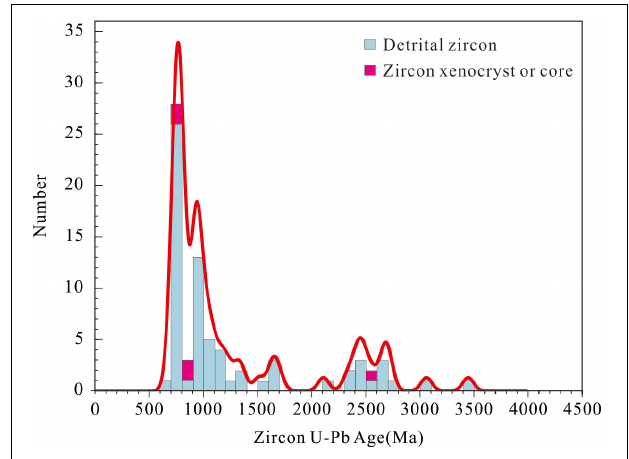
FIGURE 8 | Probability plot of detrital and xenocryst zircons from samples 15KT12, 15KT34, 15KT15, and